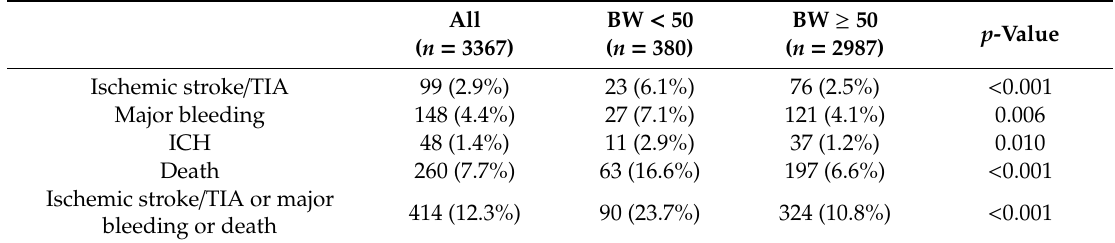
Figure 2. Rates of ischemic stroke (IS)/transient ischemic attack (TIA), major bleeding (MB), intracerebral hemorrhage (ICH), and death compared between body weight (BW) < 50 and ≥50 kg among male patients ( A ), female patients ( B ), patients aged ≥65 years ( C ), and patients aged <65 years ( D ). The chi-square test was used for analysis. A p -value < 0.05 indicates statistical significance. The rate of clinical outcomes among patients with body weight < 50 and ≥50 kg is shown in Table 2. Ischemic stroke, major bleeding, and ICH were all significantly increased when body weight was below 50 kg. Table 2. Rates of clinical outcomes compared among di ff erent body weight groups. Table 2. Rates of clinical outcomes compared among different body weight groups.